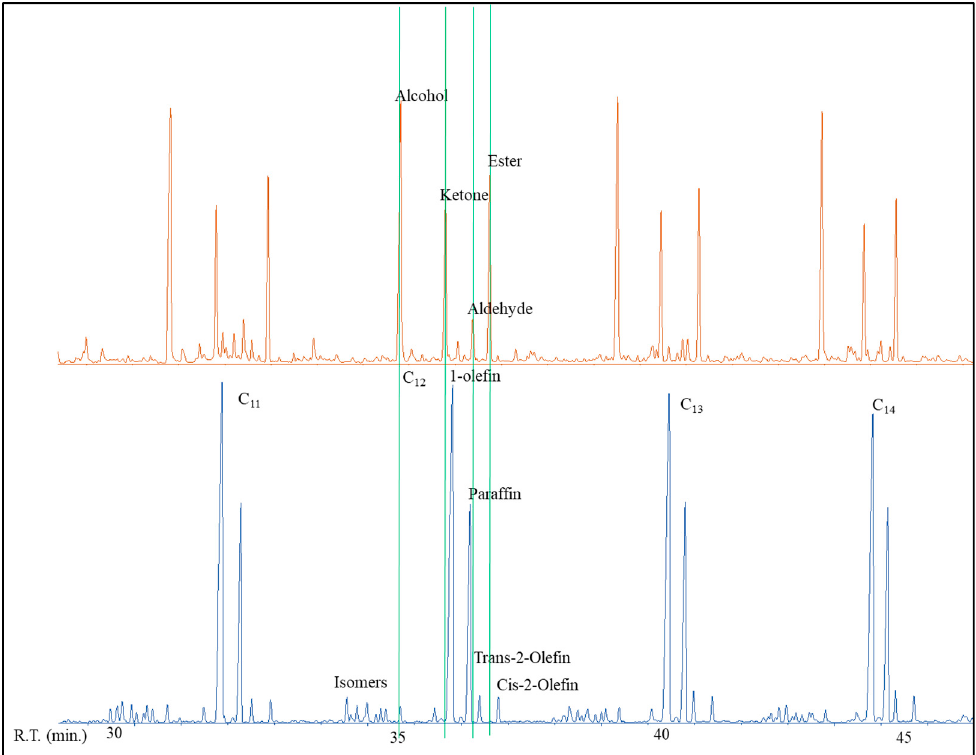
Figure 12. Two separate fractions of an iron FT oil separated by silica gel with N 2 and independently injected upon the Agilent MSD. The x-axis is retention time in minutes. The oxygenated chromatogram is only enlarged for the purpose of identification. The green lines display where the oxygenated material peaks would elute in relationship to the main hydrocarbon peaks—if these materials were not first separated.